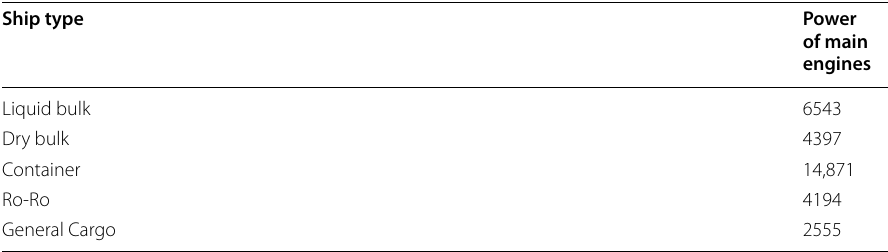
Table 10 Average power values by ship type (KW). Source Trozzi (2010)